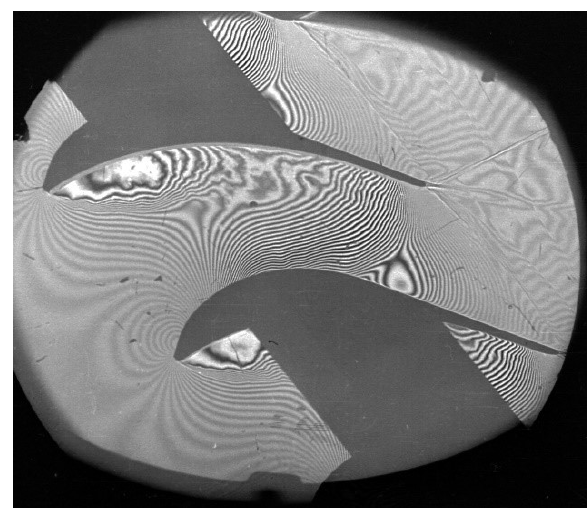
Figure 8. Flow separation on the pressure side of the blade with negative angle of incidence.